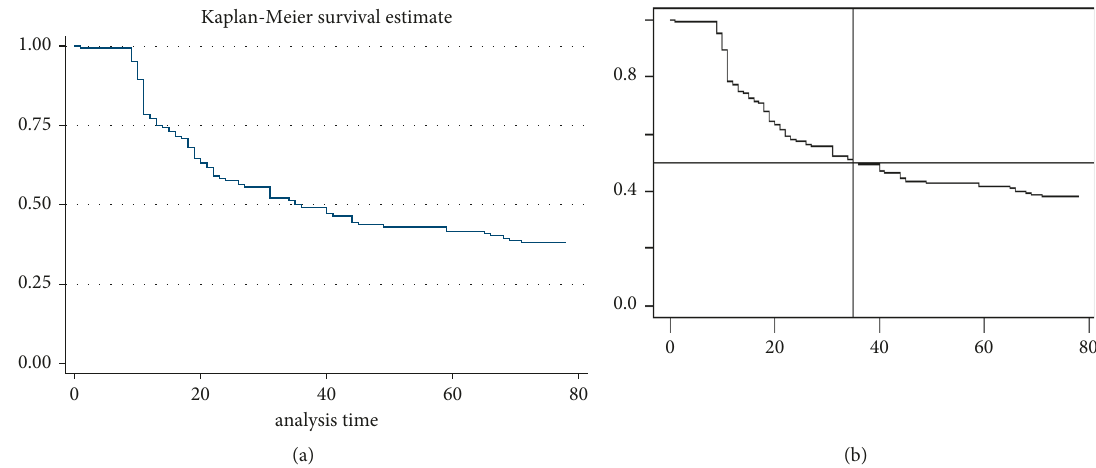
Figure 4: (a) KM survival function. (b) KM survival function with a median. Note: the horizontal and vertical straight lines in Figure 4(b) represent the mean and median waiting times for first employment, respectively.